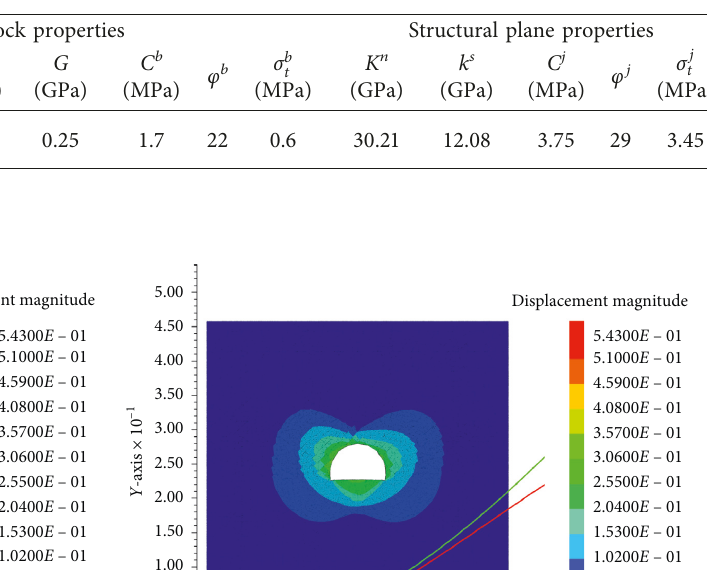
Table 2: Parameters for the rock mass.